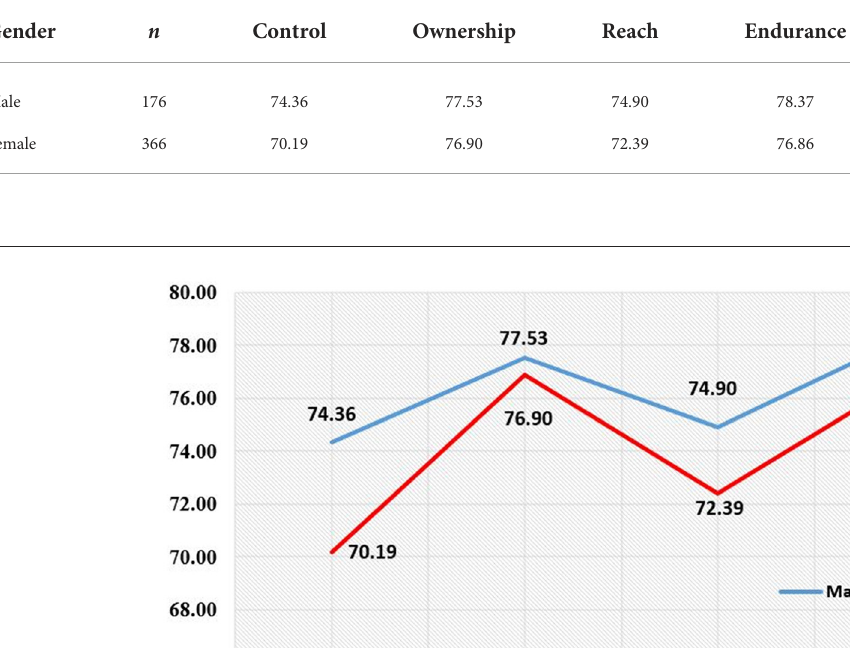
TABLE 11 AQ index values of practicum pre-service teachers by gender.